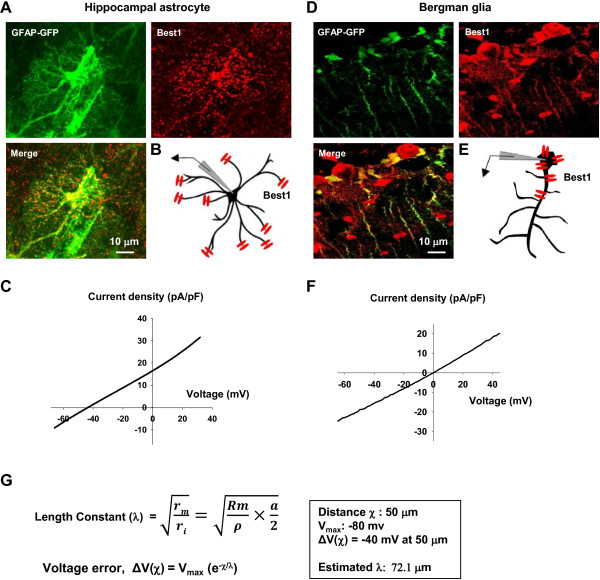
Reversal potential of Best1-mediated anion conductance in hippocampal astrocyte and bergman glial cell. A. Immunohistochemical staining of GFAP-GFP (green), Best1 (red), and merged image showing that Best1 channels are exclusively expressed in microdomain of hippocampal astrocyte. B. Schematic diagram of Best1 expression in hippocampal astrocytes. C. The representative I-V relationship of NPPB sensitive current showing anion conductance in hippocampal astorcytes. D. Immunohistochemical staining of GFAP-GFP (green), Best1 (red), and merged image showing that Best1 channels are exclusively expressed in soma of bergman glia. E. Schematic diagram of Best1 expression in bergman glia. F. The representative I-V relationship of NPPB sensitive current showing anion conductance in bergman glia. G. The formula of length constant in hippocampal astrocytes.